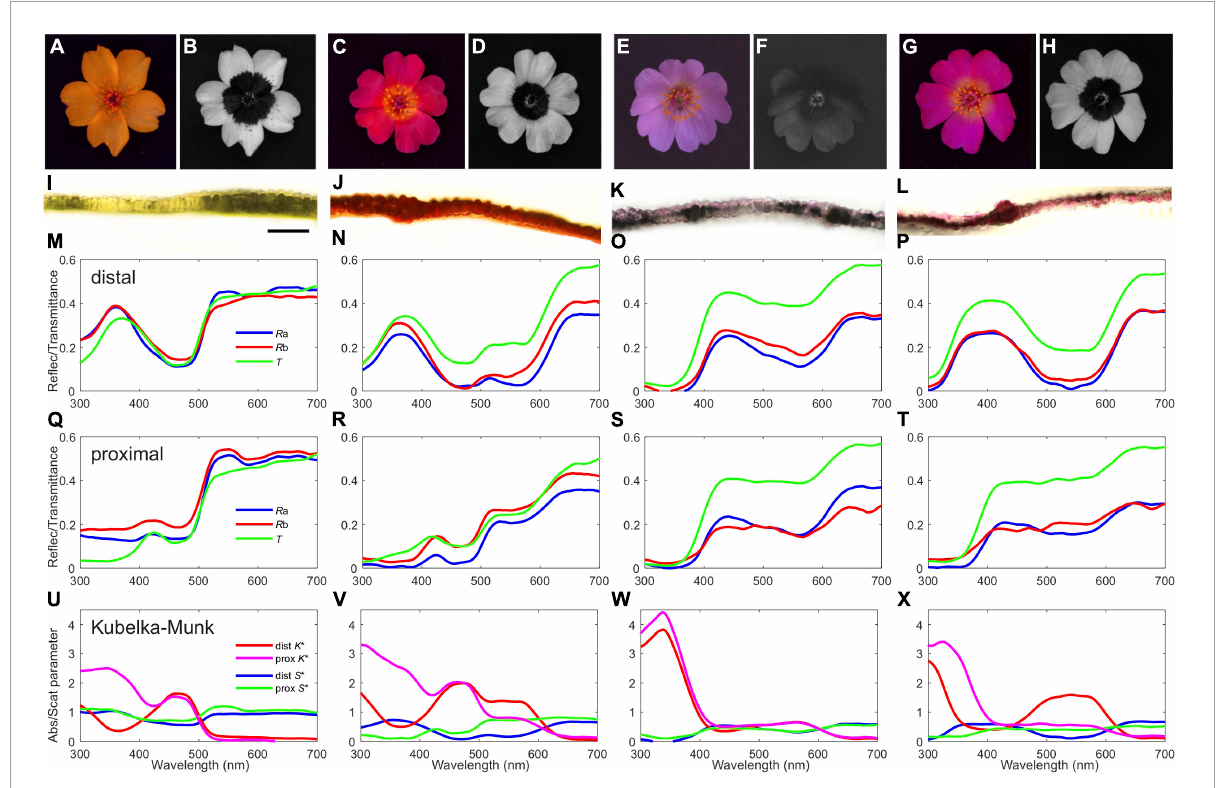
FIGURE2 Variously colored Cistanthe longiscapa flowers, petal anatomy and spectral characteristics. (A, C, E, G) RGB photographs. (B , D , F , H) UV photographs. (I–L) Transversal sections of the petals of the respective flowers above (scale bar, in I , 100 µ m). (M–P and Q–T) Reflectance ( R ) and transmittance ( T ) spectra measured with an integrating sphere from distal and proximal petal areas, respectively; R a – adaxial, R b – abaxial. (U–X) Absorption ( K *) and scattering ( S *) parameters calculated with a Kubelka-Munk procedure; dist – distal, prox –